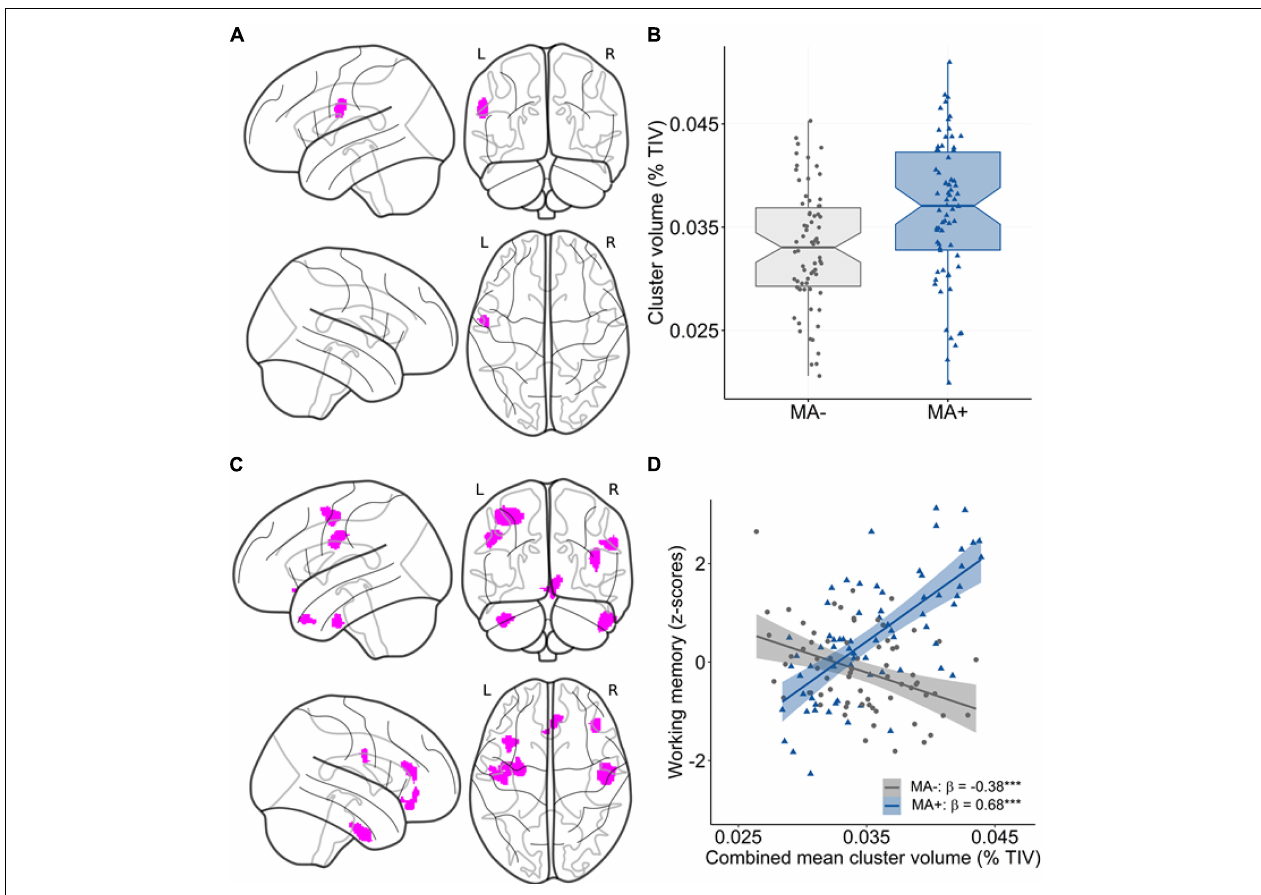
FIGURE 3 | Association between musical activity and regional volume distribution. (A,B) Results of the main effect analysis. Statistical map (A) shows significant clusters ( p < 0.001 uncorrected, color-coded in magenta) with larger GMV in participants with musical activity compared to controls. The corresponding graph (B) displays the association using mean GMV values extracted from the corresponding cluster in the postcentral gyrus. The box plot displays the median with 95% confidence intervals, interquartile range with lower (25th) and upper percentiles (75th), and individual data points. (C,D) Results of the moderation analysis. The statistical map (C) displays clusters ( p < 0.001 uncorrected, color-coded in magenta) with a significant moderation effect of musical activity. The corresponding scatter plot (D) shows the association using mean values extracted from the GMV maps in the combined cluster. Larger GMV in the combined cluster was associated with better working memory ability selectively in participants with musical activity (MA+, blue) compared to controls (MA–, gray). Individual data points, linear trends (solid lines), 95% confidence intervals (shaded areas), and standardized regression coefficients ( β ) within each musical activity group are provided. The statistical maps are depicted on a glass brain. Significance levels (uncorrected): *** p < 0.001. MA+, musical activity; MA–, no musical activity; GMV, gray matter volume; TIV, total intracranial